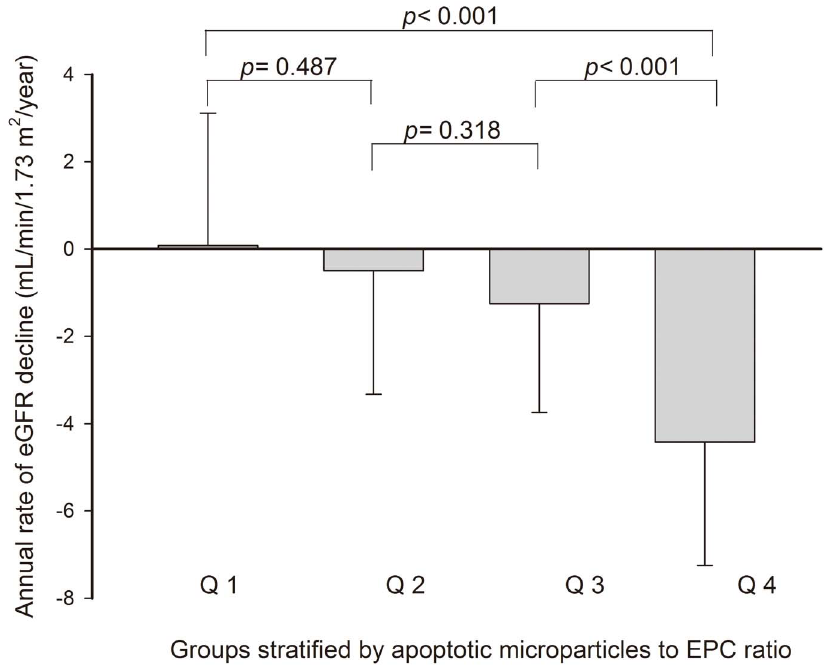
Figure 2. The annual rate of eGFR decline in the study groups stratified by EMP/EPC ratio. All patients were divided into 4 groups according to EMP/EPC ratio in quartiles: group 1 (Q1), with EMP/EPC ratio # 0.5; group 2 (Q2), with EMP/EPC ratio . 0.5 and # 2.0; group 3 (Q3), with EMP/EPC ratio . 2.0 and # 11.7; group 4 (Q4), with EMP/EPC ratio . 11.7. As seen, there was a significantly positive association between the EMP/EPC ratio and the subsequent decline in eGFR.